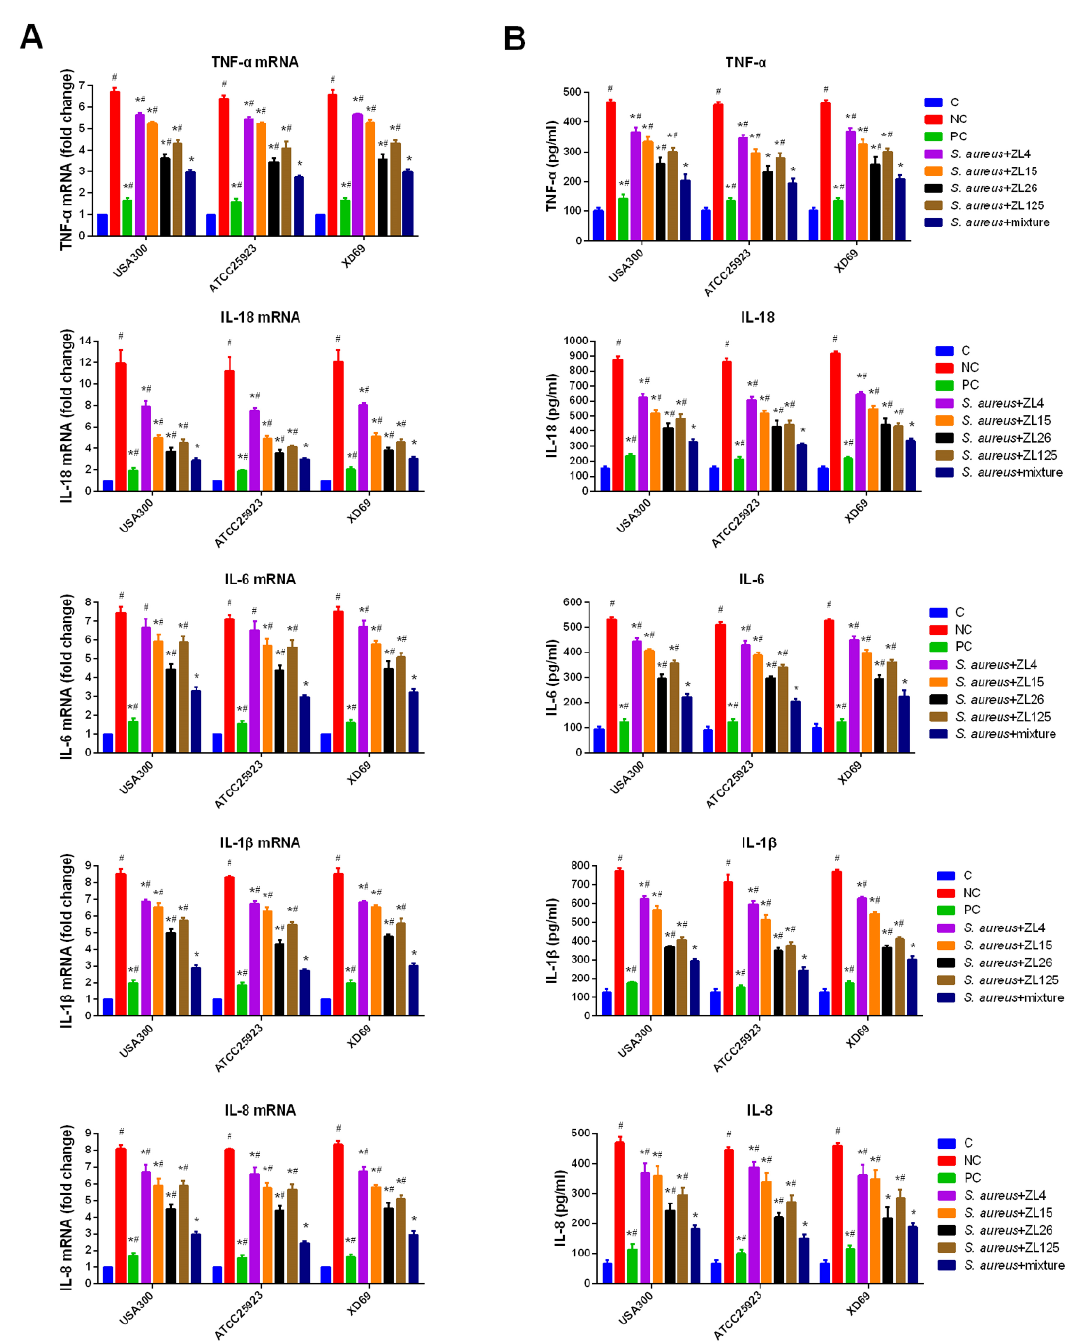
Figure 8. Functions of scFvs on production of proinflammatory cytokines in mammary gland tissues. ( A ) Transcription levels of TNF- α , IL-18, IL-6, IL-1 β , and IL-8 detected by qPCR method in mammary gland tissues; ( B ) expression level of TNF- α , IL-18, IL-6, IL-1 β , and IL-8 detected by ELISA method in mammary gland tissues. GAPDH was used as control gene. Data represent mean results ± SD ( n = 6). # p < 0.05 vs. scFvs mixture group. * p < 0.05 vs. negative control group.